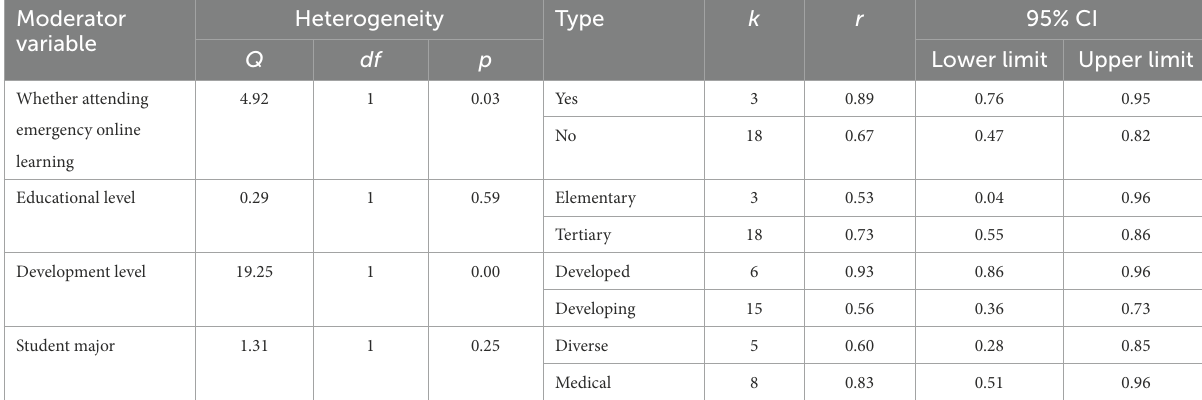
TABLE 8 Moderator analysis for the prevalence of stress.